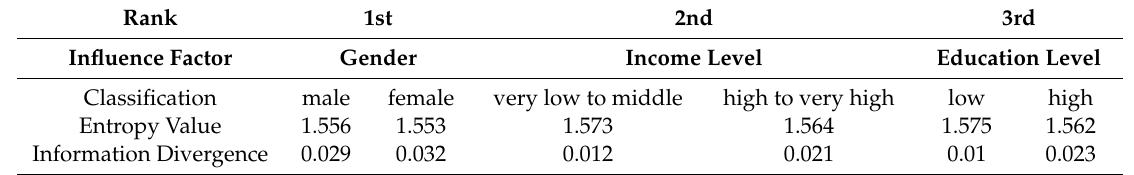
Table 1. Top three distinguishable factors for water footprint consumption.